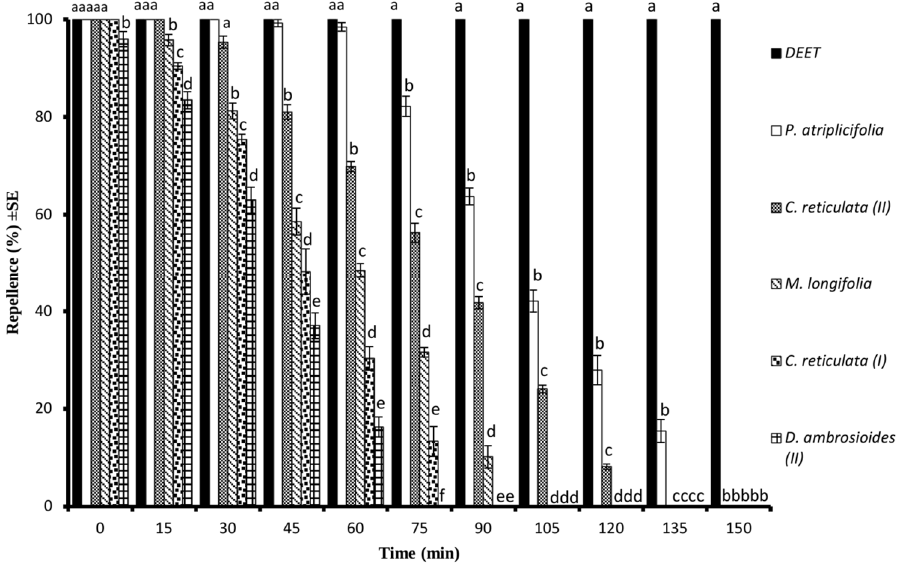
Figure 4. Time span mosquito repellency of different essential oils and DEET at the tested dose of 330 μ g/cm 2 against Ae. aegypti females. Different letters on the bars show a significant difference ( p < 0.05) among different test substances at a specific period. Error bars on each column represent standard error where n = 5.